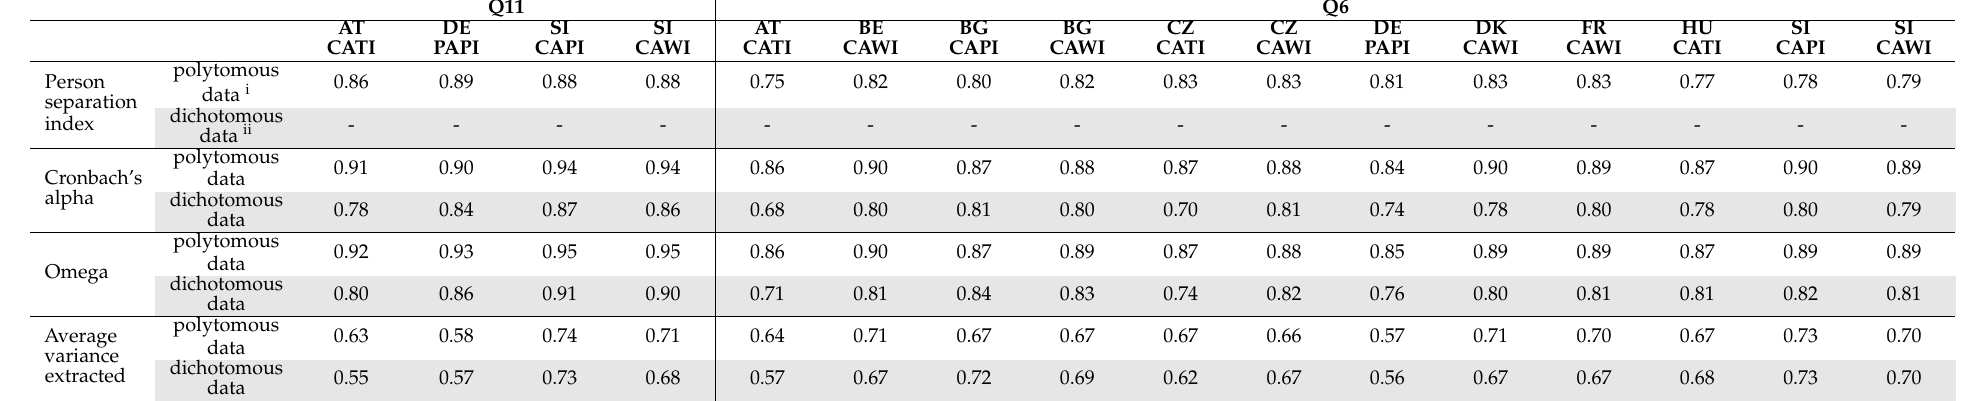
Table 6. Reliability indices for the HLS 19 -COM-P-Q11 (left) and HLS 19 -COM-P-Q6 (right), for each country, divided by data collection mode. Calculation of Person separation index is based on polytomous data, whereas Cronbach’s alpha, omega and average variance extracted are displayed for both polytomous and dichotomous (marked in grey)